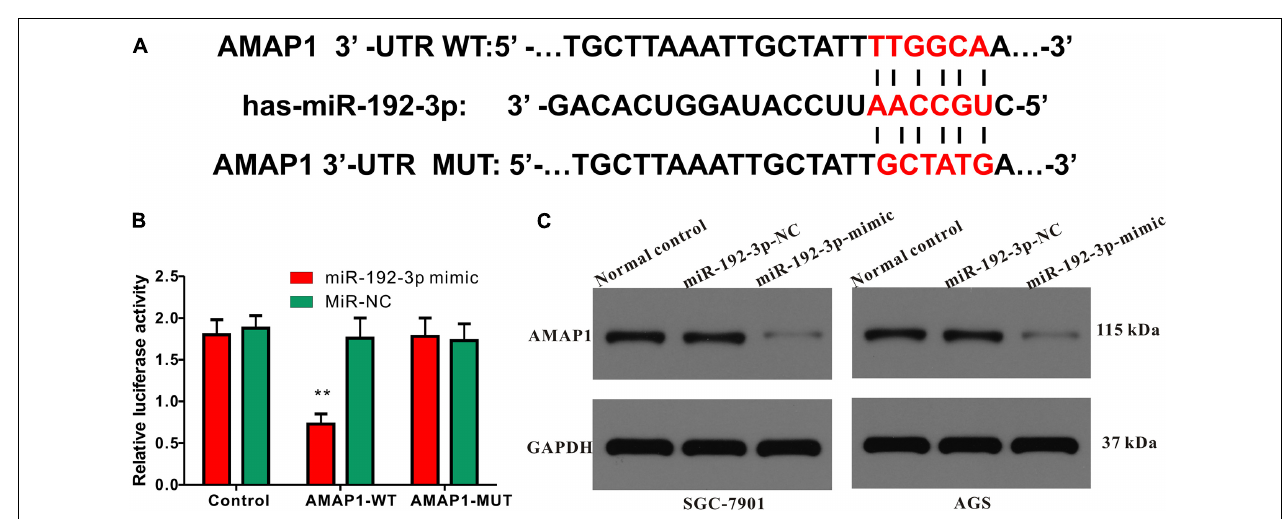
FIGURE 8 | AMAP1 is the target of miR-192-3p. (A) The potential binding sequence between AMAP1 and miR-192-3p. (B) Dual-luciferase reporter gene assay reveals that AMAP1 is the binding target of miR-192-3p. (C) Western blot was applied to detect the expression of AMAP1 protein in HGC-7901 and AGS cells transfected with miR-192-3p mimics or miR-192-3p -NC or control. ** P < 0.01.